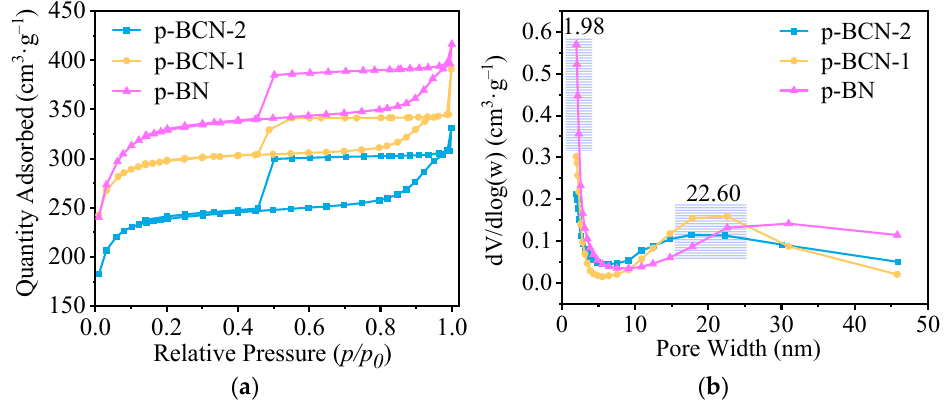
Figure 4. ( a ) N 2 adsorption–desorption isotherms. ( b ) The corresponding pore size distributions calculated by the BJH method of samples.